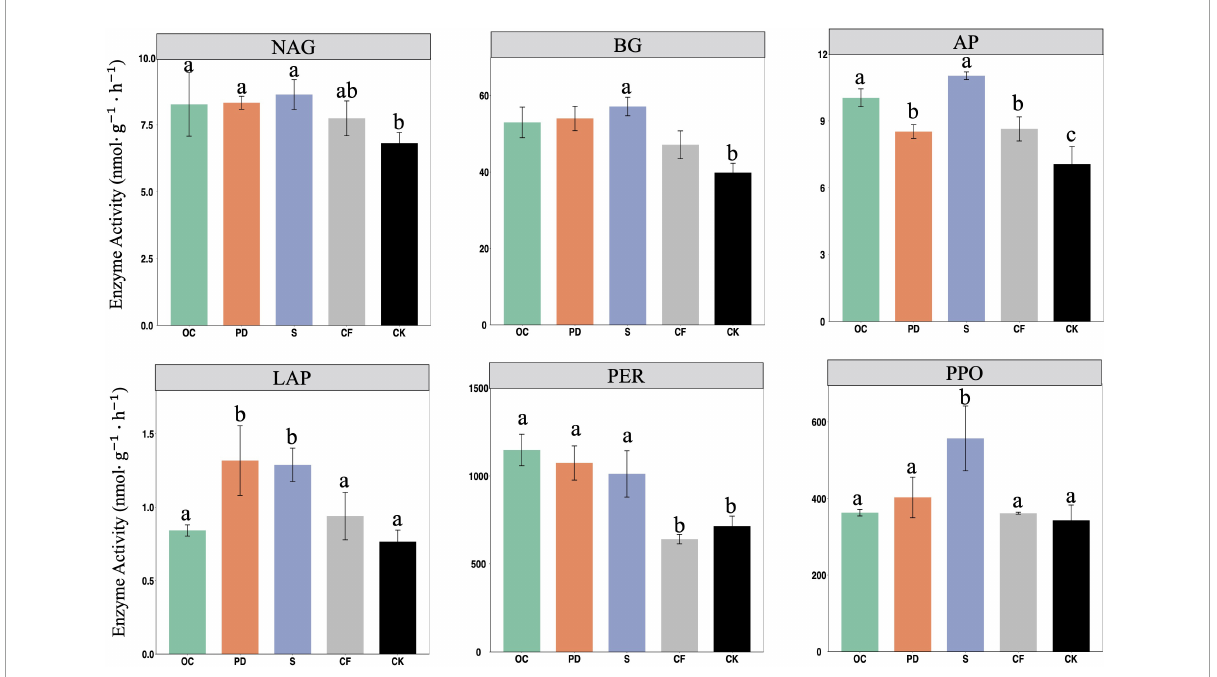
FIGURE2 The activities of extracellular enzymes NAG, AP, BG, LAP, PER, PPO in soil under fertilizations oil cake (OC), pig manure (PD), straw (S), chemical (CF) and no fertilization (CK) after 12-year tobacco-maize rotation. See Supplementary Table 2 for abbreviations. Data are means ± SE. Significant differences were determined by ANOVA, Fisher’s least significant difference (LSD) test ( P < 0.05) and indicated by different